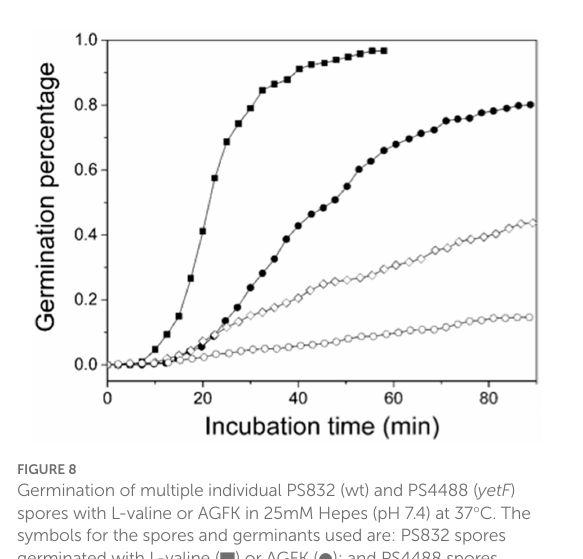
FIGURE 8 Germination of multiple individual PS832 (wt) and PS4488 ( yetF ) spores with L-valine or AGFK in 25 mM Hepes (pH 7.4) at 37 ° C. The symbols for the spores and germinants used are: PS832 spores germinated with L-valine ( ■ ) or AGFK ( ● ); and PS4488 spores germinated with L-valine ( ◇ ) or AGFK ( ○ ). The germination of ~300 individual spores was followed as described in